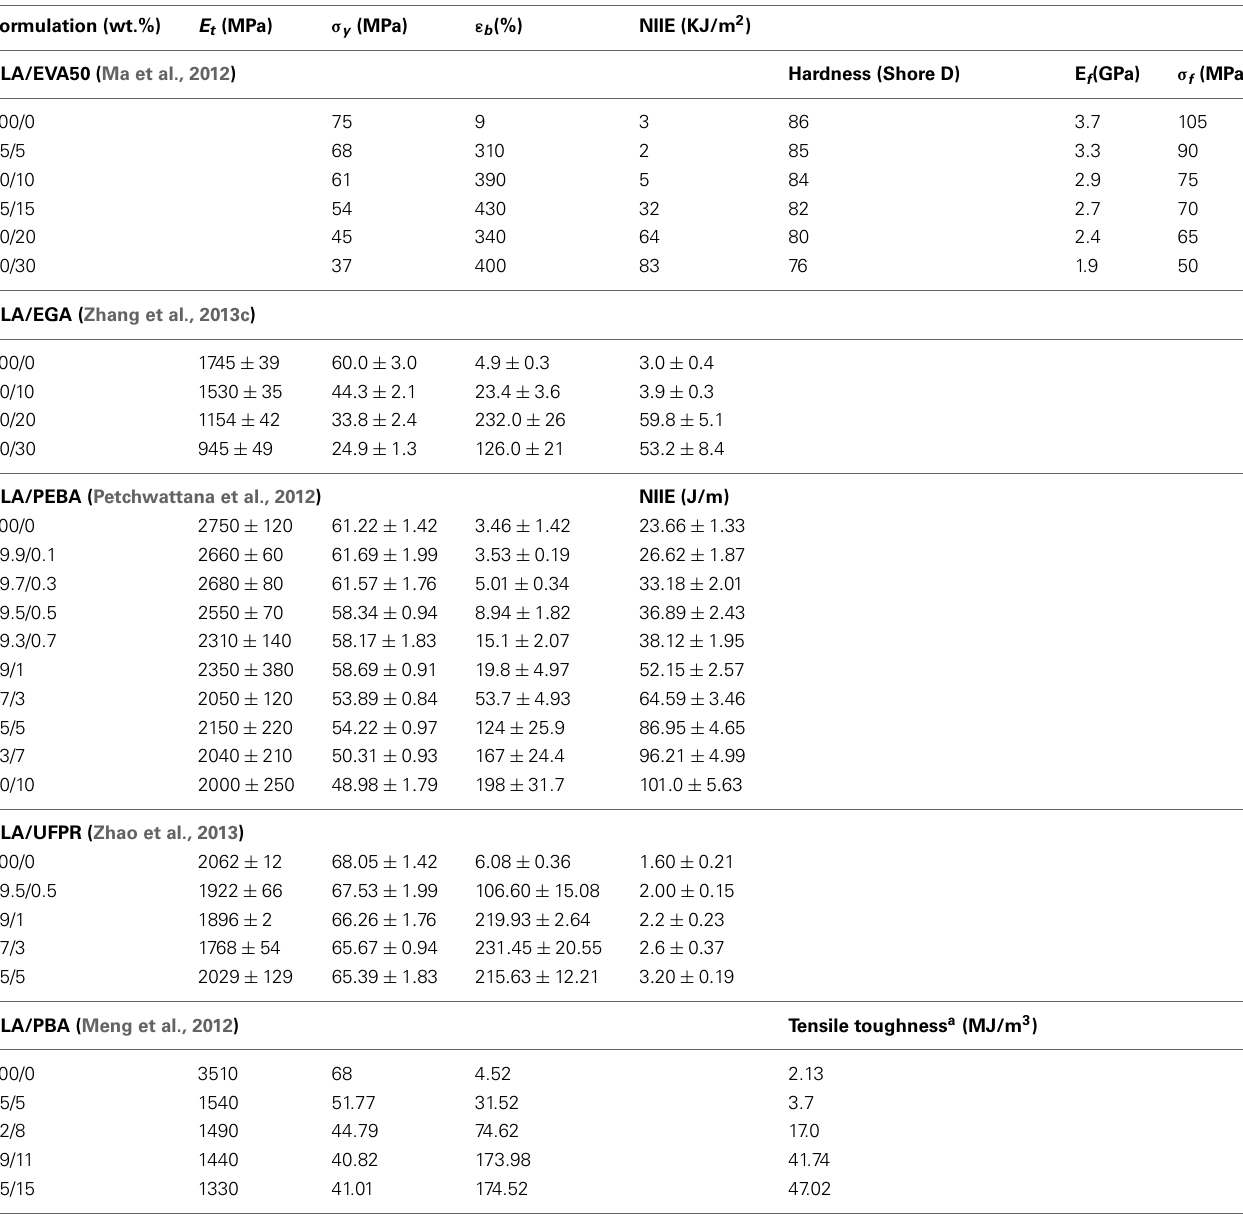
Table 11 | Mechanical properties of different PLA blends with non-biodegradable flexible/soft polymers. Formulation